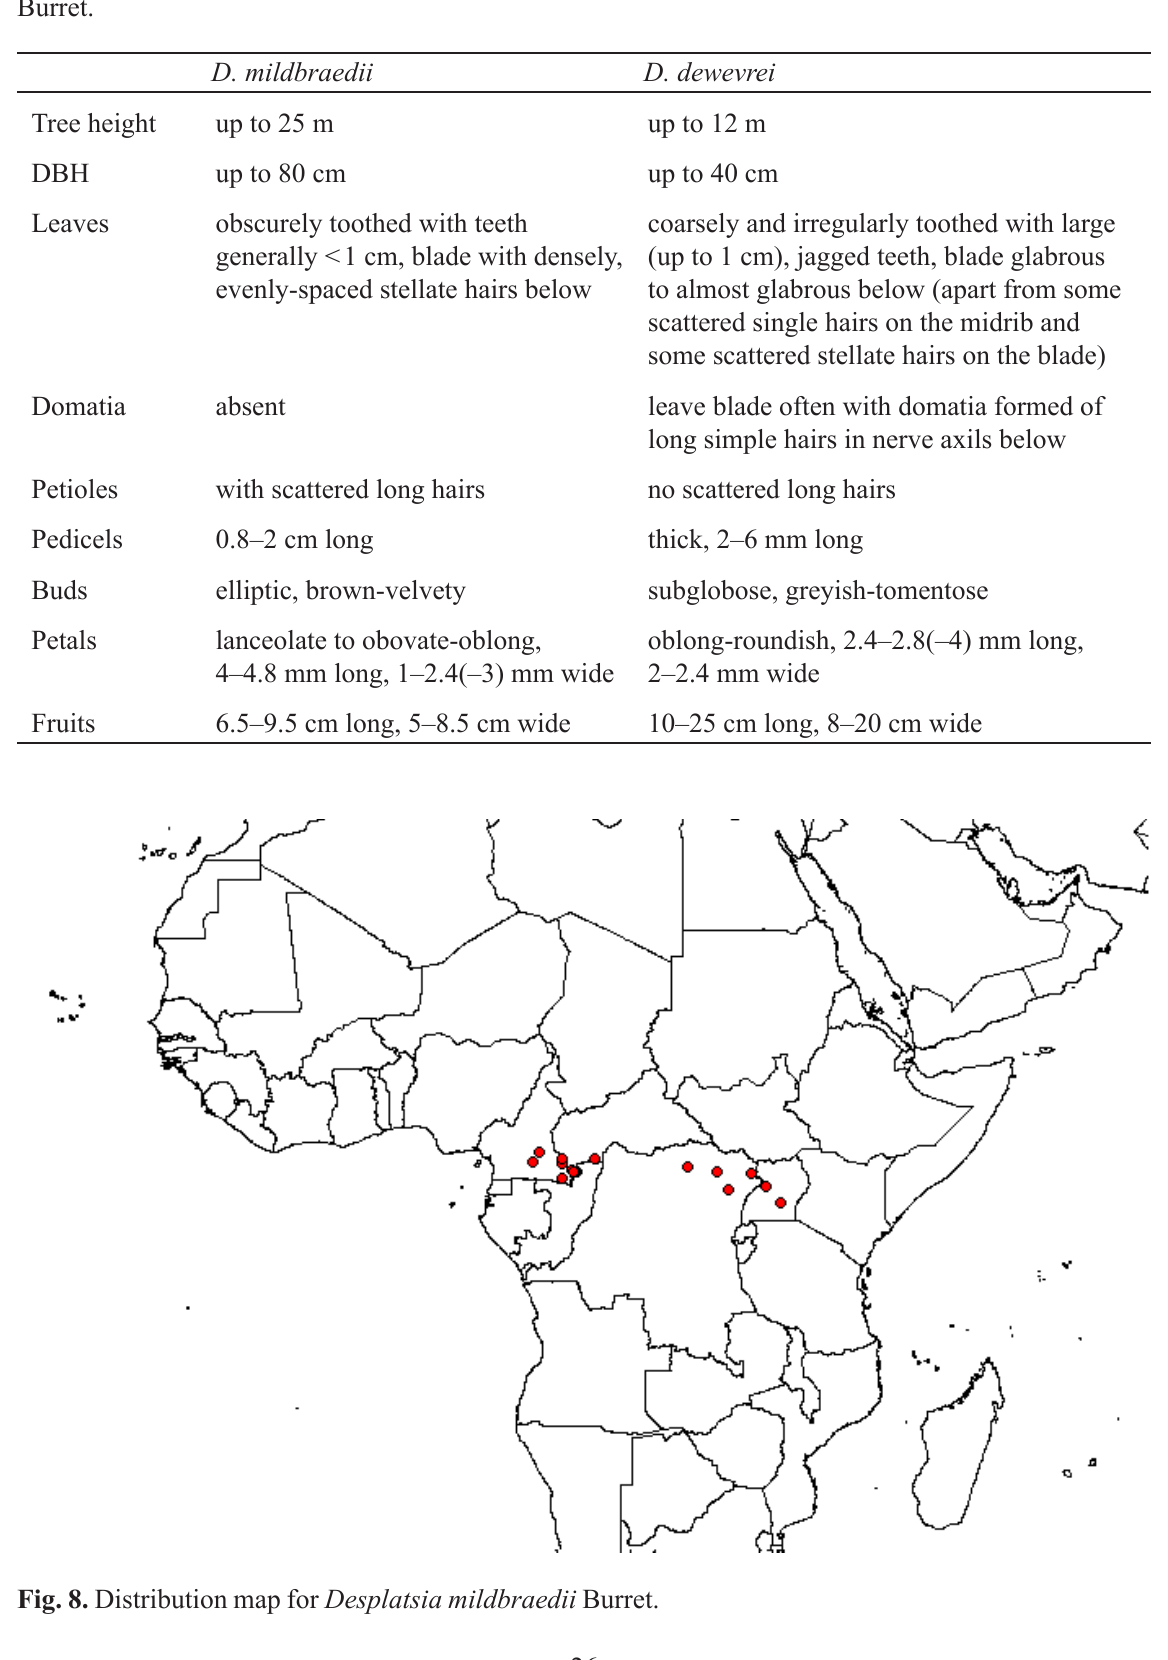
Table 1. Characters separating Desplatsia mildbraedii Burret from D. dewevrei (De Wild. & T.Durand) Burret.